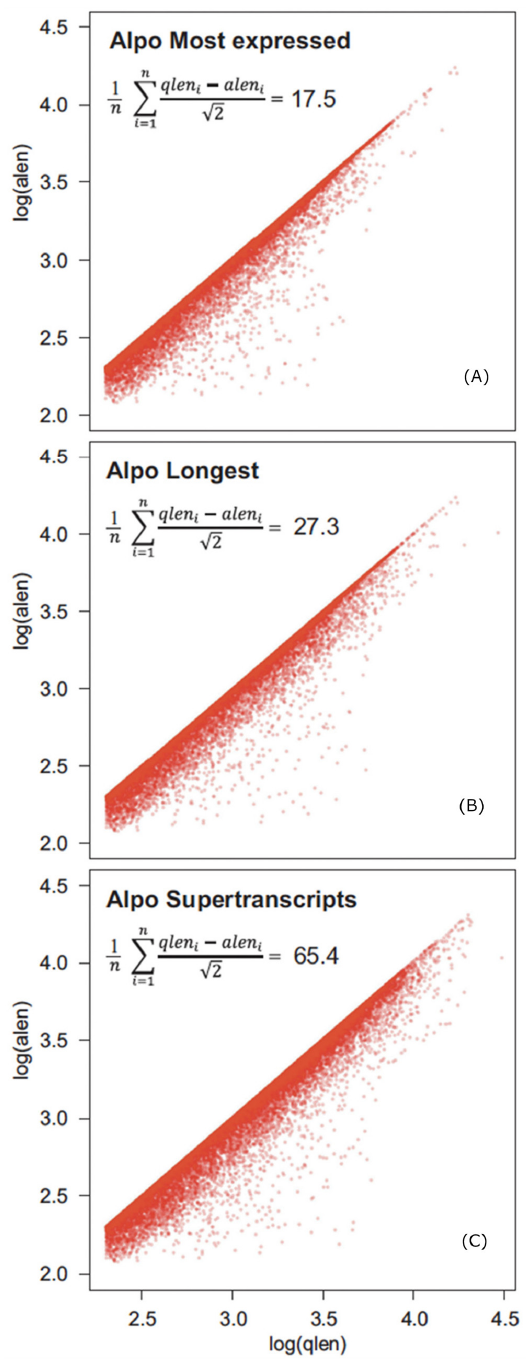
Figure 2. Alpo-CDC Redberry length alignments. The query lengths ( qlen ) of the most expressed transcript ( A ), the longest transcript ( B ), and the SuperTranscript ( C ) were plotted against the length of the aligned sequence in CDC Redberry ( alen ). An averaged summation function was also computed with the distances of each point to a perfect alignment (diagonal).